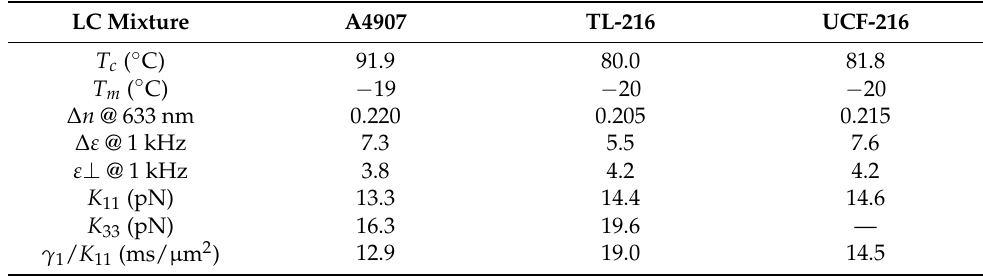
Table 1. Measured physical properties of DIC A4907, MerckTL-216 and UCF-216 at T = 22 ◦